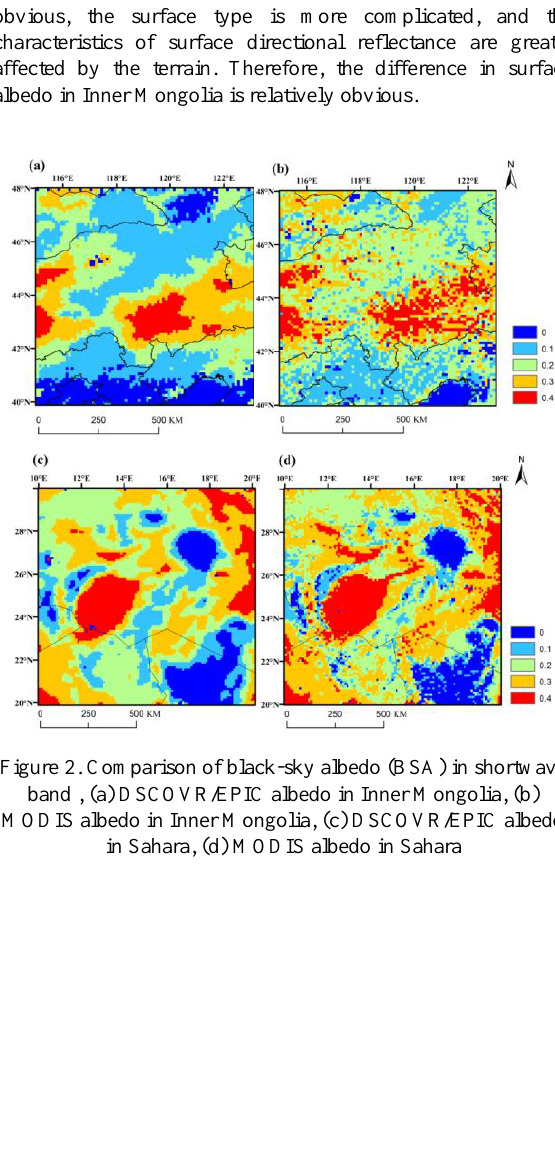
Figure 1. The global distribution of DSCOVR/EPIC short wave black-sky Albedo (BSA) after temporal filtering on 4 th June, 2016